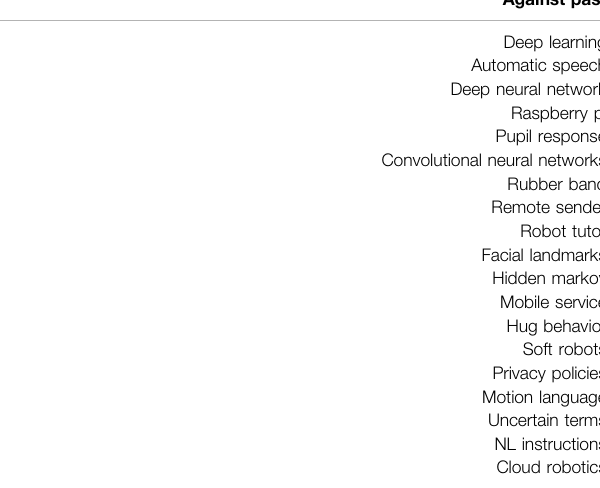
TABLE 2 | Contrastive analysis: range 2005 – 2009. Against all